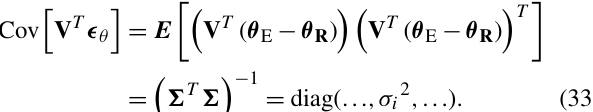
Figure 6. Wind states observed using the linear model for different steady inflow conditions at 5ms − 1 : yaw misalignment φ at χ κ h 0 . 1 (a) , vertical shear κ v at χ = − and φ 8 ◦ (d) = −